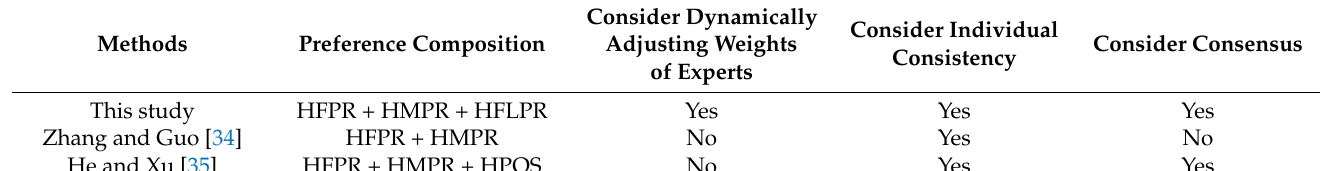
Table 5. Comparisons between the proposed method and the existing method.